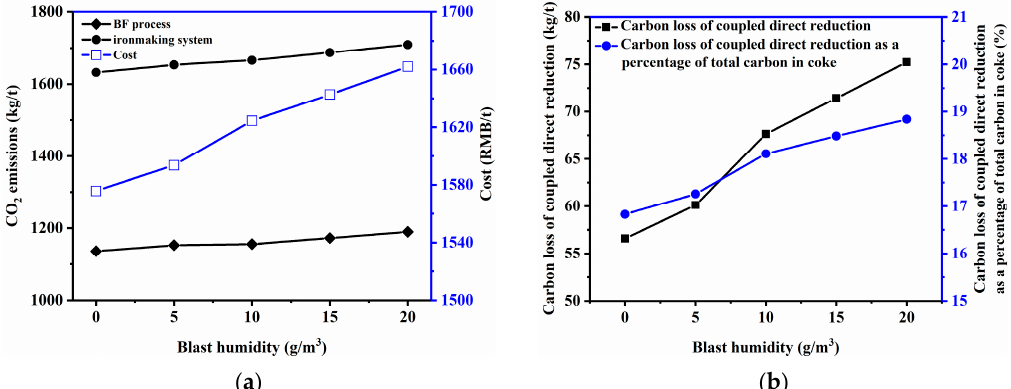
Figure 4. ( a ) Effect of blast humidity on cost and CO 2 emissions; ( b ) Effect of blast humidity on carbon loss of coupled direct reduction and its percentage of total carbon in coke.